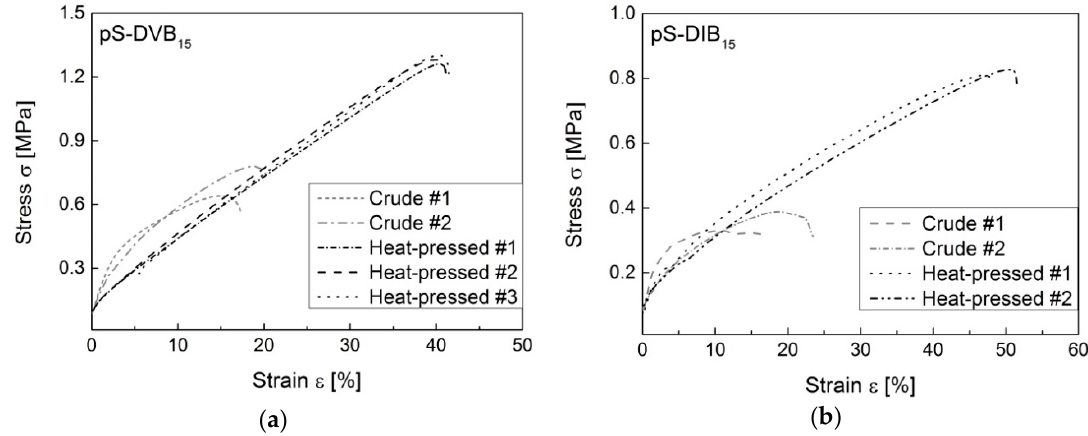
Figure 10. Comparison of ductility experiments of crude and hot-pressed sulfur copolymers. The diagrams show copolymers with 15 wt % incorporated monomer content: ( a ) pS-DVB; ( b ) pS-DIB.